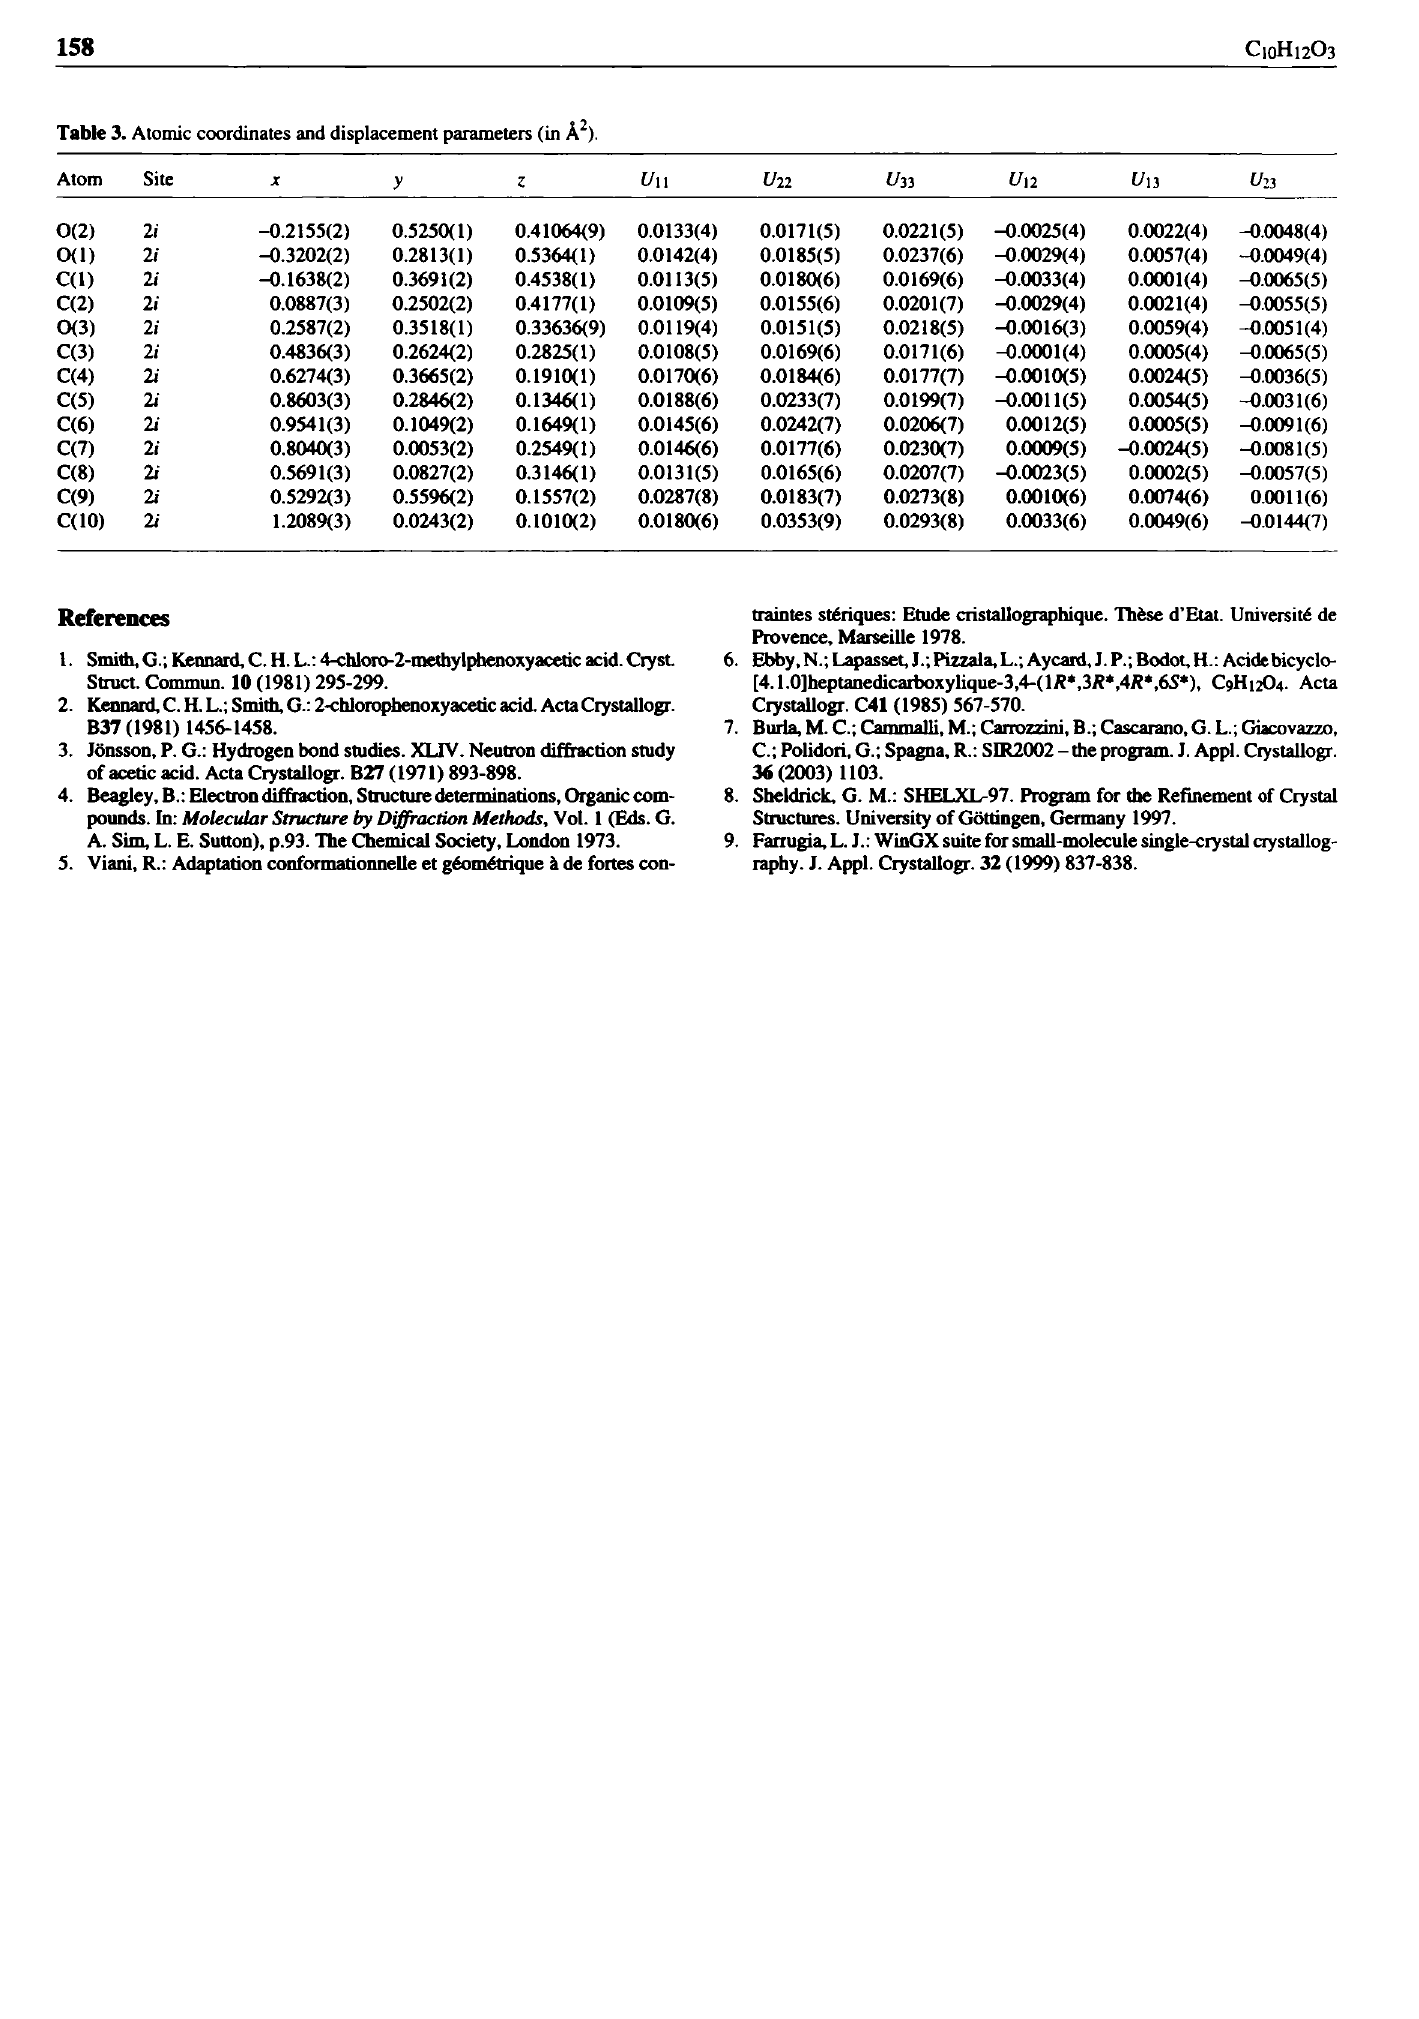
Table 3. Atomic coordinates and displacement parameters (in A 2